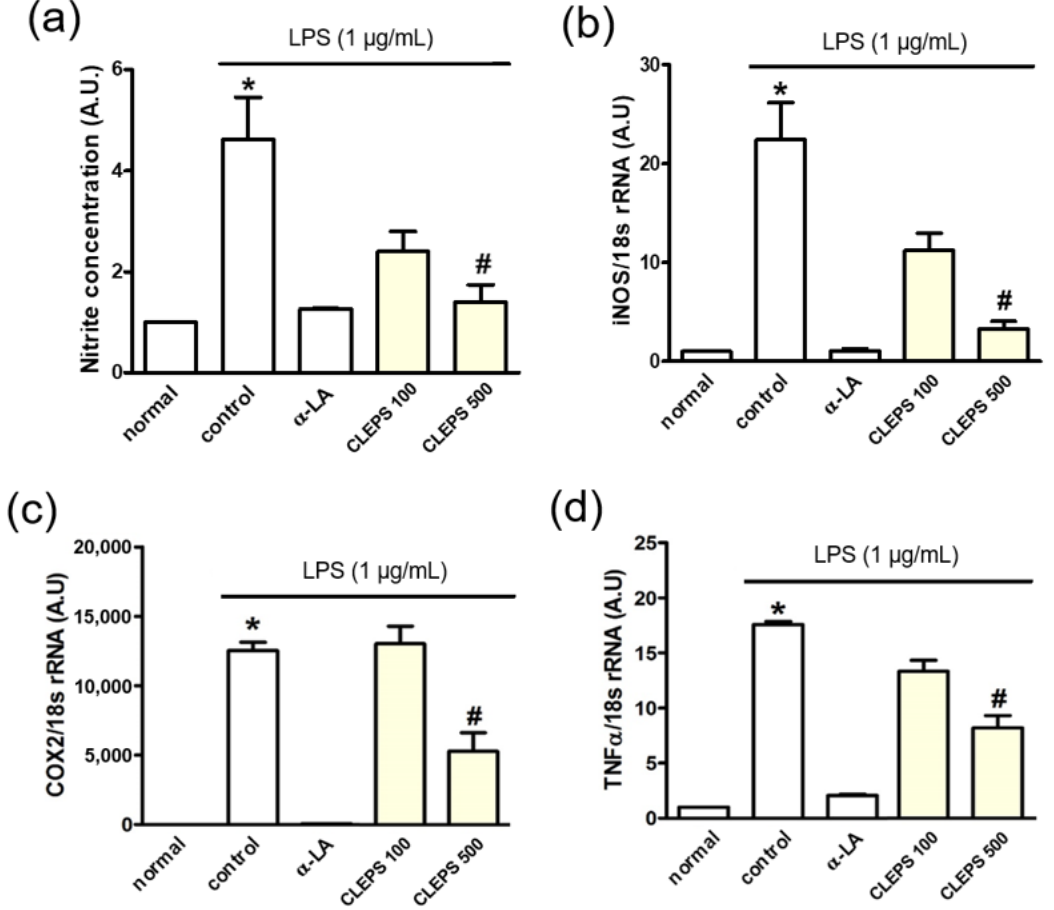
Figure 4. Anti-inflammatory effects of CLEPS (100-500 µ g/mL) by inhibiting the inflammatory factors, including NO ( a ), iNOS ( b ), COX2 ( c ), and TNF α ( d ). * p < 0.05 vs. normal, # p < 0.05 vs.